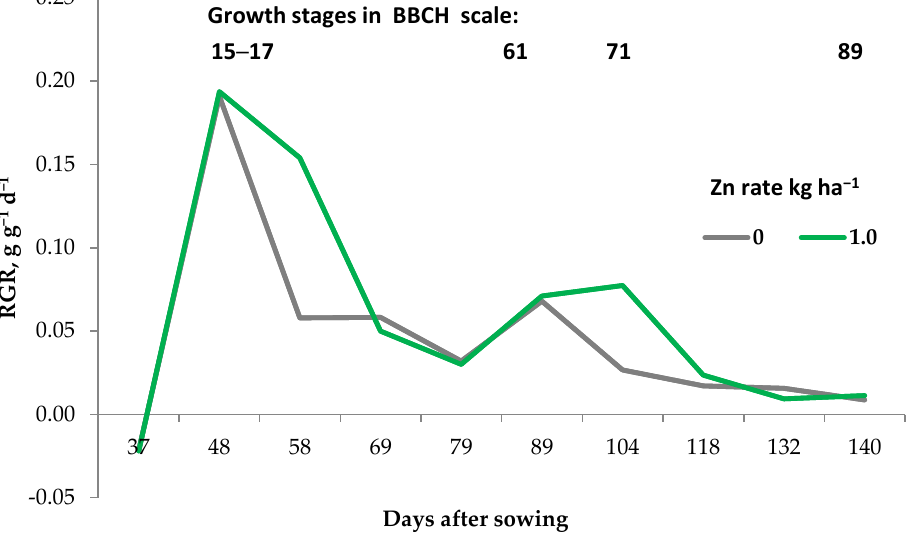
Figure 7. Relative growth rate (RGR) of maize during the growing season in response to foliar zinc (Zn) application (based on Grzebisz et al. [31] — modified).